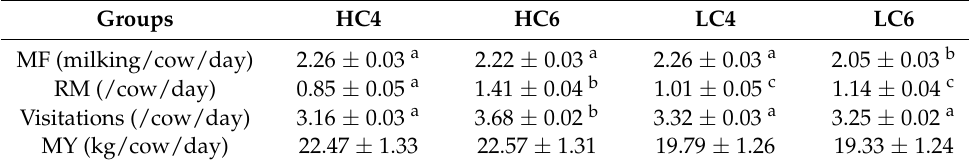
Table 5. Analysis of the trafficking behaviour of the four initially formed